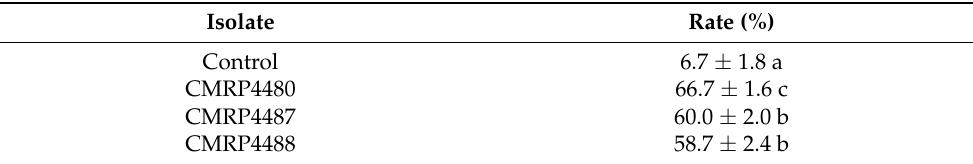
Table 3. Mortality rates of Lema bilineata Germar (Coleoptera: Chrysomelidae) eggs after inoculation with conidial suspensions (10 8 conidia mL − 1 ) of three isolated Beauveria bassiana strains. Data are means ± standard